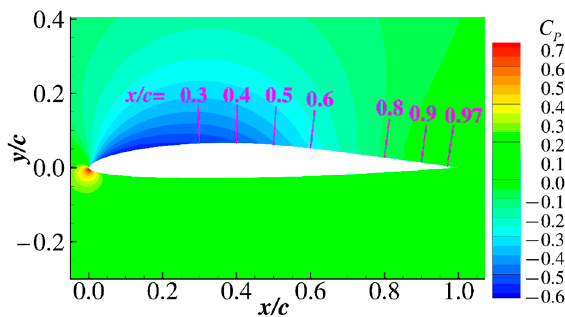
Figure 12. Skin friction coefficient of the wing without and with riblets.